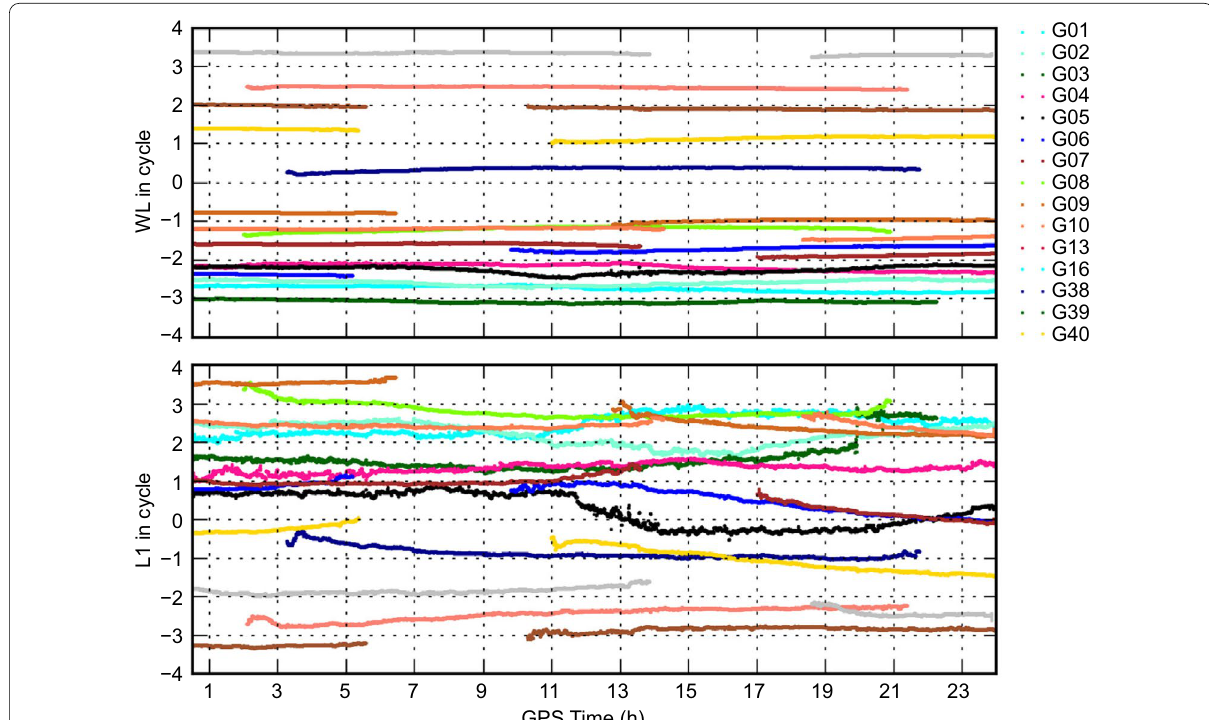
Fig. 2 Time series of hardware WL (top) and L1 biases (bottom) for BeiDou GEO/IGSO